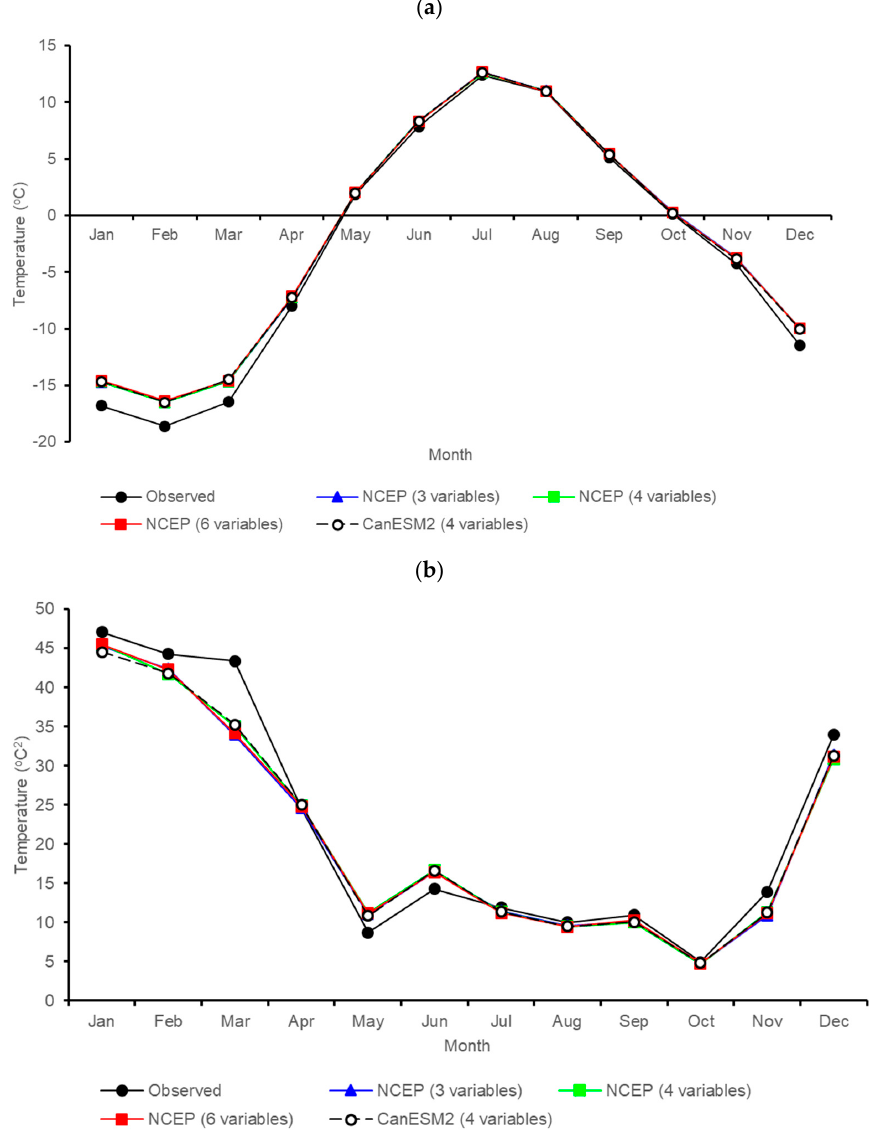
Figure 3. Comparison between the observed monthly 5 cm soil temperature and the predicted values from the CanESM2 and NCEP models for: ( a ) mean; ( b ) variance. Table 3. r correlation between the four selected variables and observed soil temperature, with bolded numbers indicating the model variable having a stronger correlation on the soil temperature than the other model.